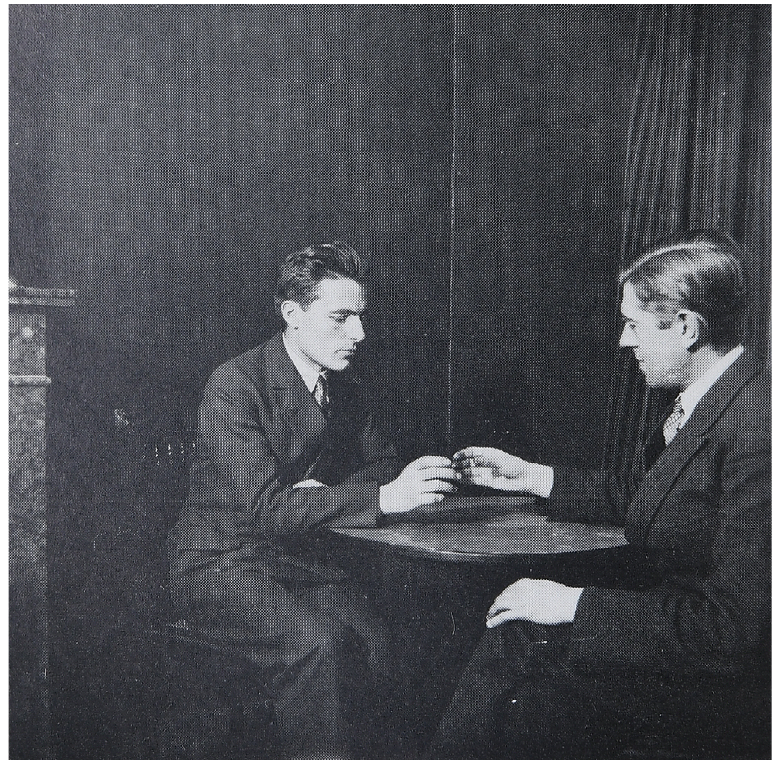
Fig. 2 Marc. Eemans (on the left) and René Magritte (on the right), photograph taken by Paul Nougé in